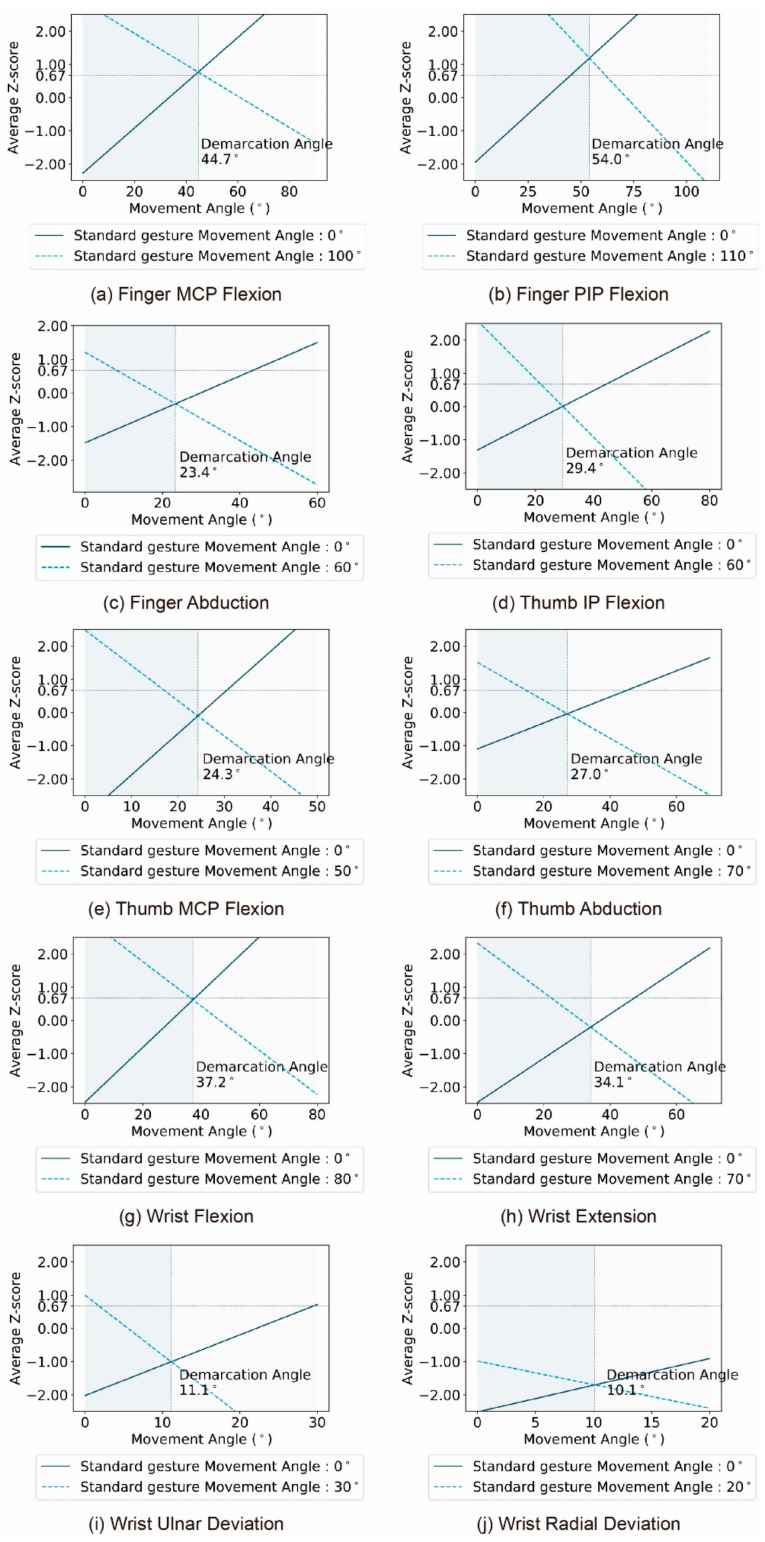
Figure 7. The visual semantic difference perception change curve of the movement primitive unit under different boundary gestures. The two curves in each chart represent the semantic difference changes in visual perception when the contrast gesture was compared with each of the two boundary gestures. The reference line with the ordinate of 0.67 is used as the difference boundary. It is generally believed that, when the average Z score exceeds 0.67, the contrast stimulus and the standard stimulus have a perception difference